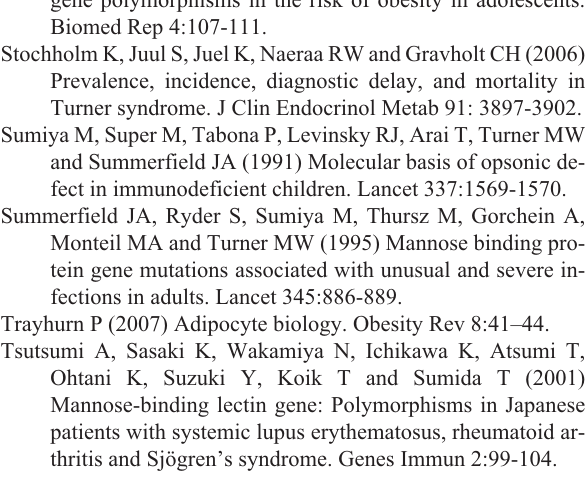
Table S2 – Detailed statistics results for CTLA-4 rs231775 (A/G). Table S3 – Detailed statistics results for Combined Alleles . Table S4 – Detailed statistics results for the MBL2 gene and promotor region Table S5 – Detailed statistics results for the haplotypes (LYA, HYA, LXA, LYO, HYO) of the MBL2 gene. Table S6 – Detailed statistics results for the genotypes (High